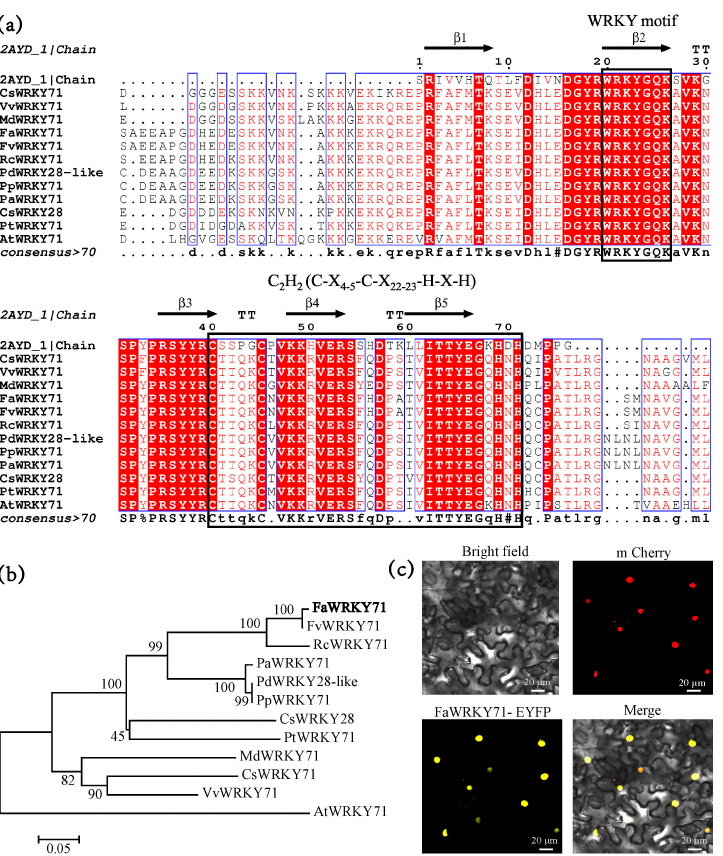
Figure 1. Sequence analysis and subcellular localization of FaWRKY71. ( a ) Alignment of the WRKY motif and C2H2 zinc finger structure of FaWRKY71 proteins with it ′ s homologous in other species. The black box indicates the WRKY domain and C2H2 motif. ( b ) Phylogenetic analysis of FaWRKY71. The bold font stands for FaWRKY71. FvWRKY71 ( Fragaria vesca ): XP_004303874.1;